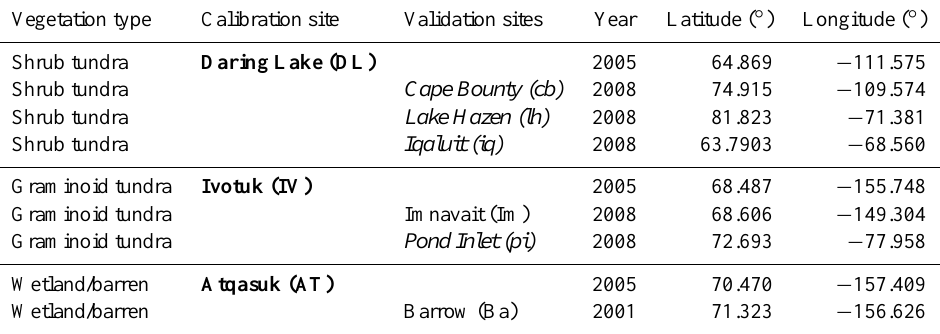
Table 3. Calibration and validation sites for each vegetation type, years of data used, and locations. Calibration sites are in bold, and validation sites at which cold season EC observations were unavailable are